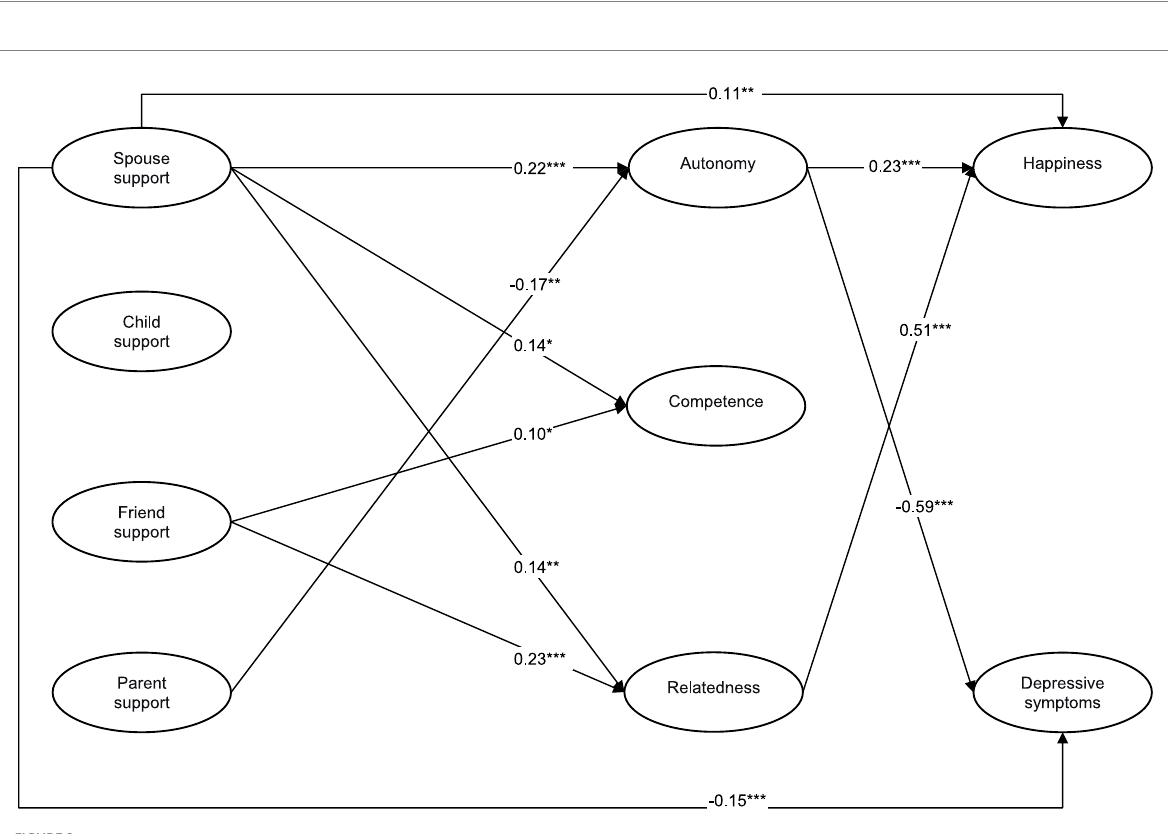
FIGURE 2 The mediating effects of satisfaction of needs on the associations between social support and well-being. n = 807; * p < 0.05. ** p < 0.01. *** p <